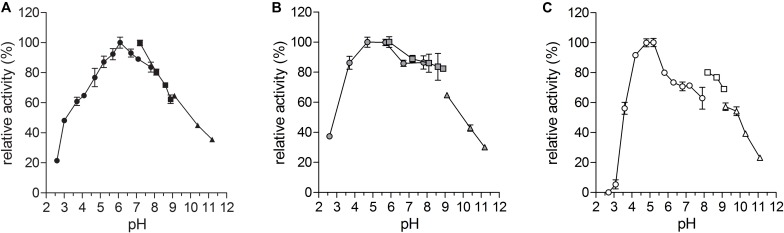
pH optima of ApLAO, CgLAO and CgmycLAO. pH range for activity of ApLAO (A), CgLAO (B), and CgmycLAO (C) as analyzed using L-Leu as substrate: pH 2.6 to pH 7.8, phosphate-citrate buffer (circles); pH 6 to pH 9, K-phosphate buffer (squares); pH 9 to pH 11, carbonate-bicarbonate buffer (triangles). Data are means ± standard deviation.